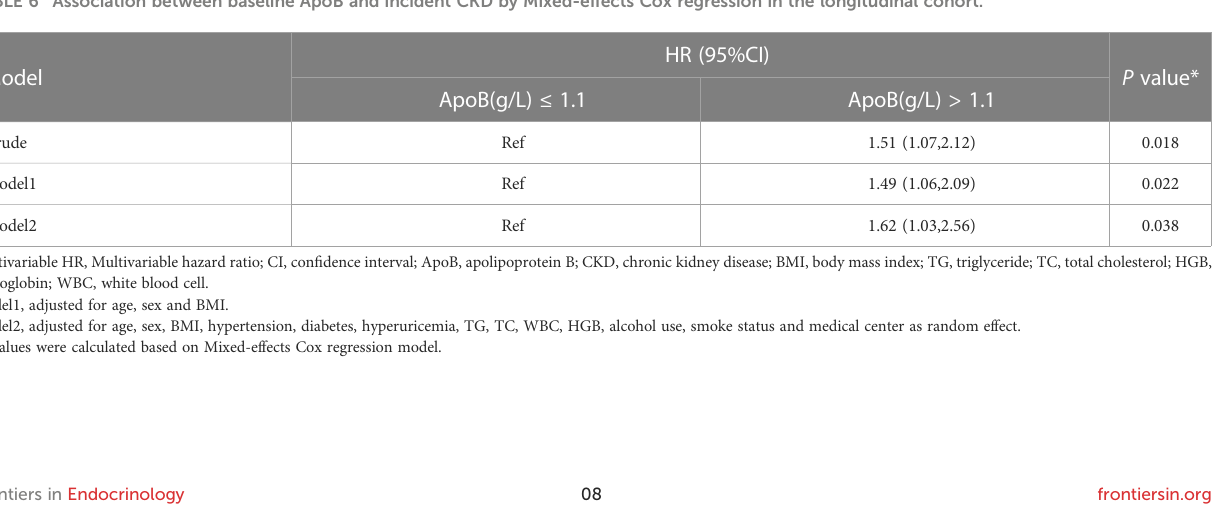
TABLE 6 Association between baseline ApoB and incident CKD by Mixed-effects Cox regression in the longitudinal cohort.